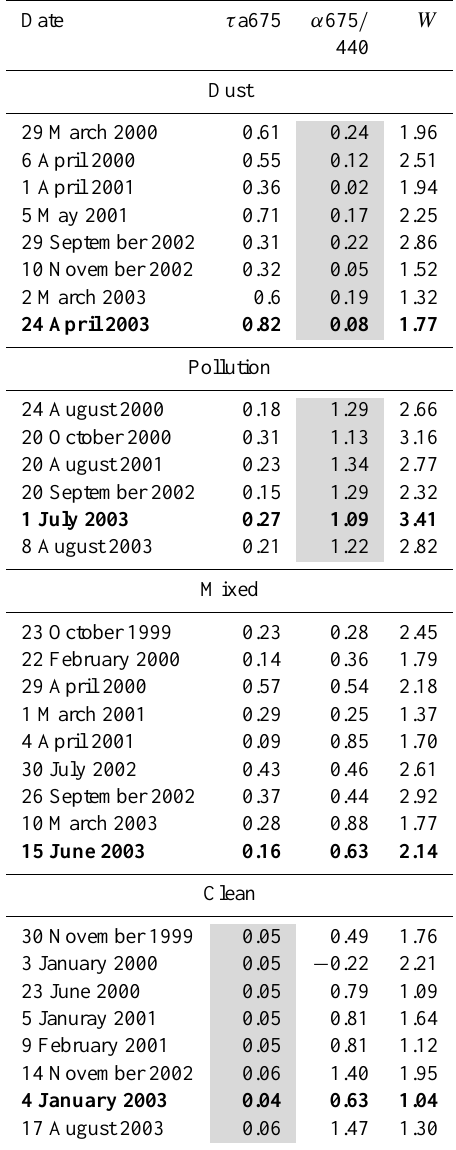
Table 2. Characterization of the aerosol types over Alexandria, Egypt, for selected dates. Back ward trajectories’ are shown for dates in bold (Fig. 5). Shaded cells represent great variations as- sociated with the specified atmospheric scenario in the highlighted